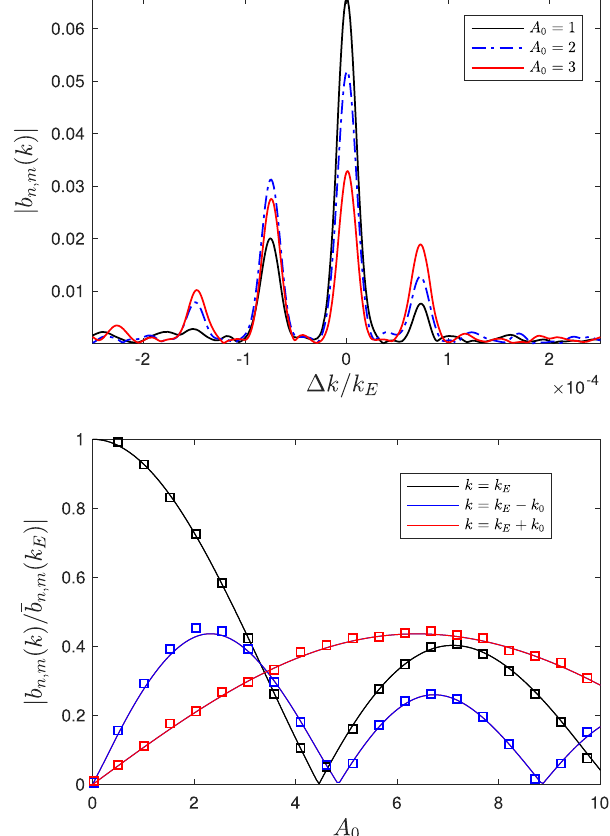
FIG. 8. Top: Bunching and sideband spectra for different A 0 with a E ¼ 100 , A 1 ; 2 ¼ 3 , n ¼ − 1 , and k 0 ¼ j k 1 ξ E = 2 B j . Bottom: Bunching amplitudes as a function of A 0 . Solid lines are predictions from the analytic model, squares are from numerical